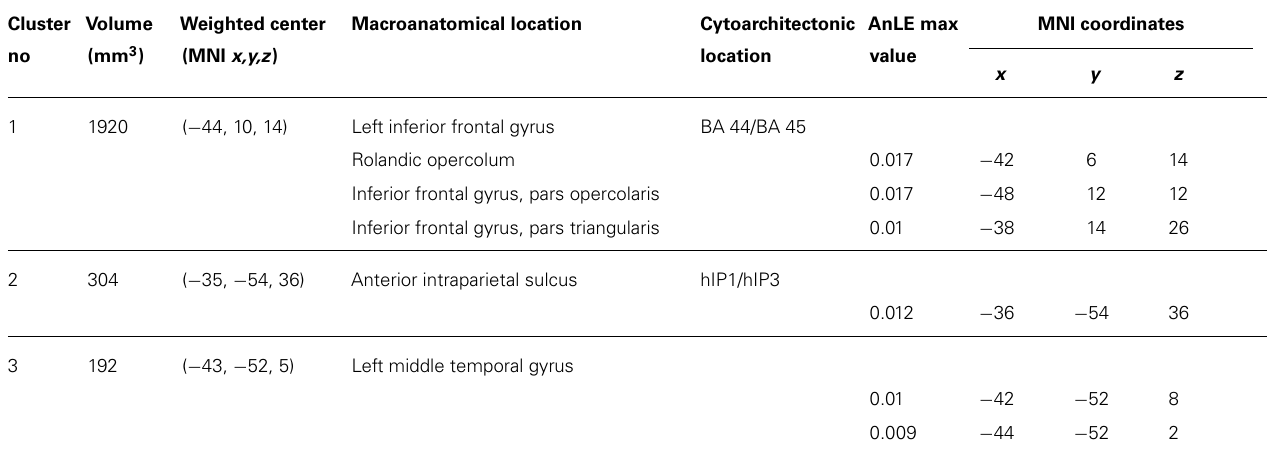
Table 2 | SignificantAnLE clusters and MNI coordinates of the corresponding local maxima identified in the inferior frontal cortex (IFC), inferior parietal cortex (IPC), and middle/superior temporal cortex (MTC/STC).